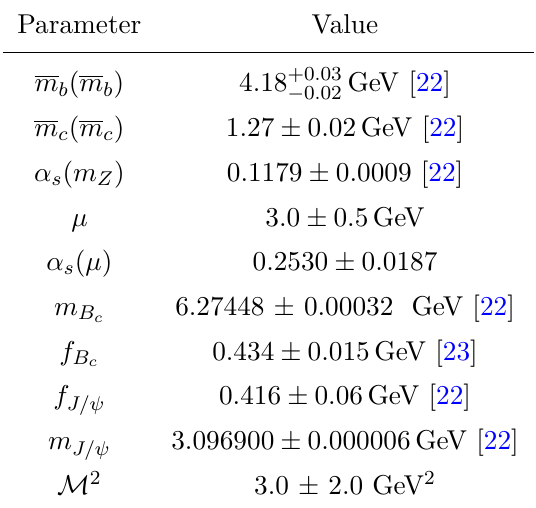
Table 1 . Input parameters used in the sum rules